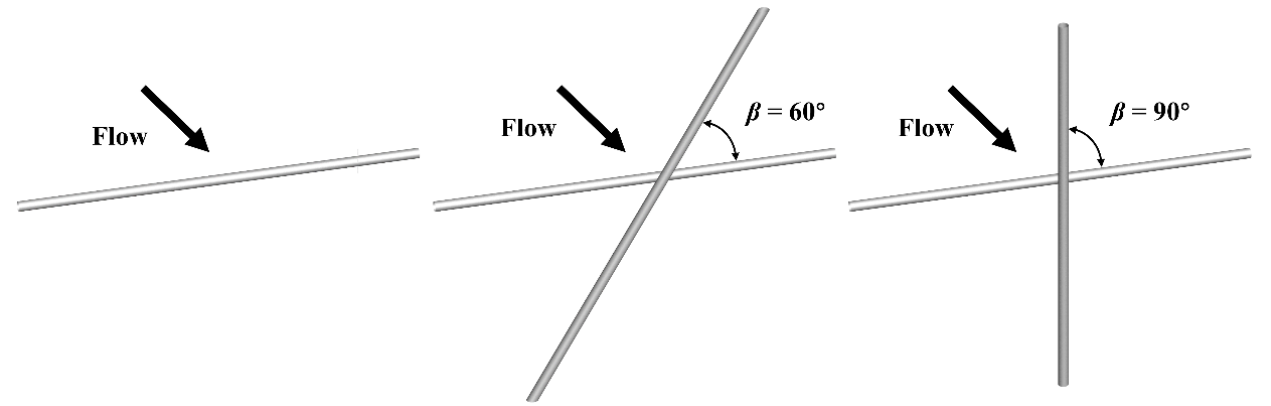
Figure 1. Sketch of single- and two-crossing circular cylinders configurations.